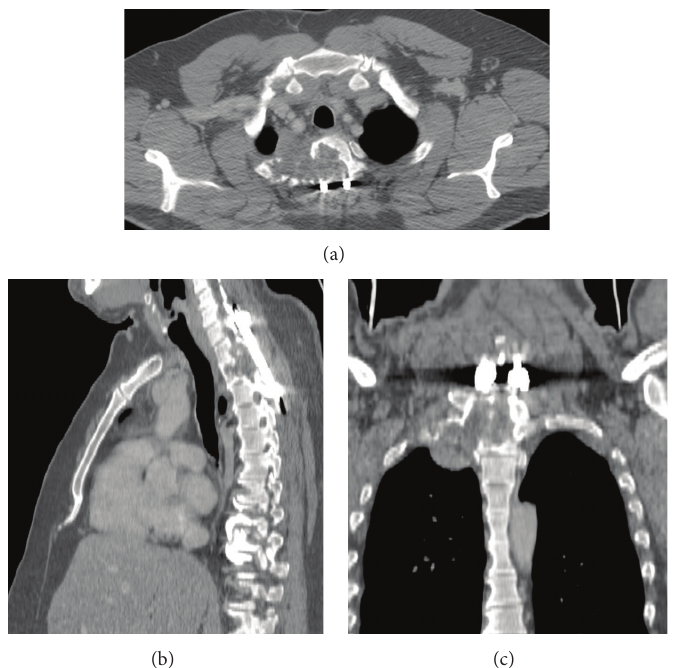
Figure 5: CT exam axial, sagittal, and coronal planes (a), (b), and (c) reveal a recurrence at the level of D1 and D2 vertebrae and the presence of cystic tissue in the chest on the